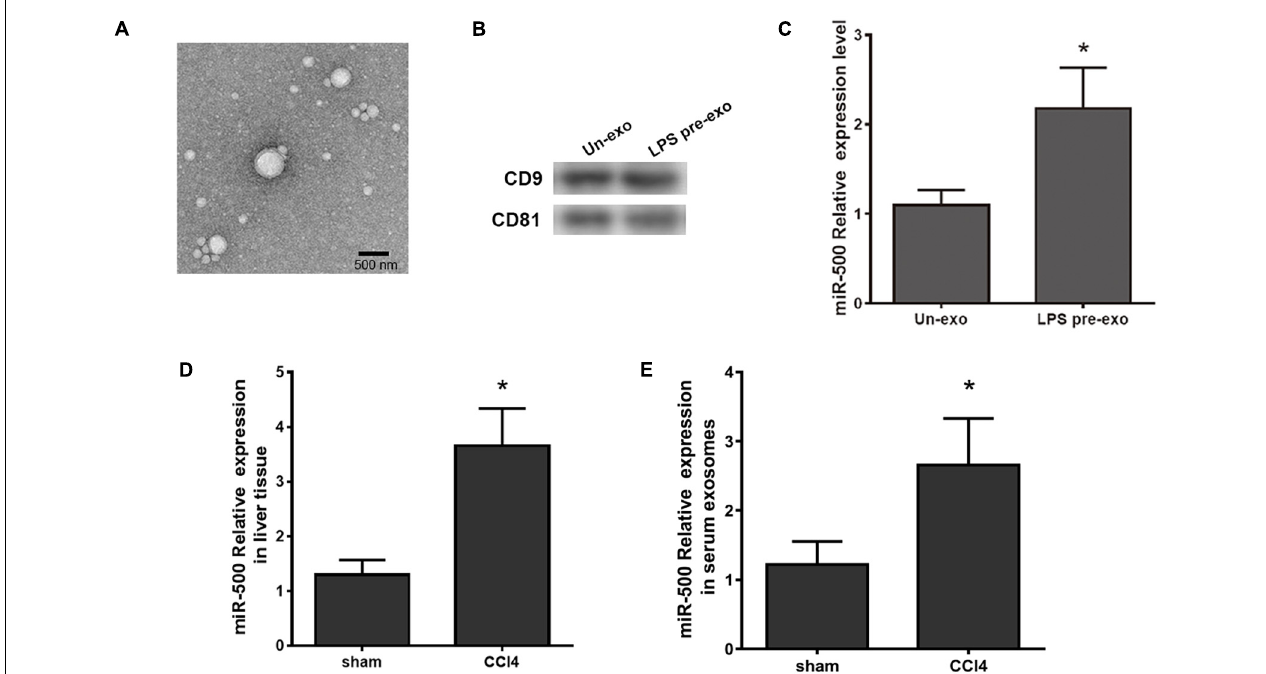
FIGURE 1 | Exosomes derived from LPS-activated macrophages have higher expression level of miR-500. (A) Exosomes were isolated from LPS-pretreated macrophages (LPS pre-exo) and non-pretreated macrophages (un-exo), and then visualized by TEM. The representative image is shown. (B) The protein level of CD9 and CD81 in exosomes were detected by western blotting assays. (C) The expression levels of miR-500 in exosomes isolated from LPS pre-exo and un-exo were detected by real time PCR. (D) The expression levels of miR-500 in CCl 4 -induced liver fibrosis mice were detected by real time PCR. (E) The expression levels of miR-500 in serum exosomes isolated from CCl 4 -induced liver fibrosis mice and control mice were detected by real time PCR. These results are mean ± SD of three independent experiments. * P < 0.05.